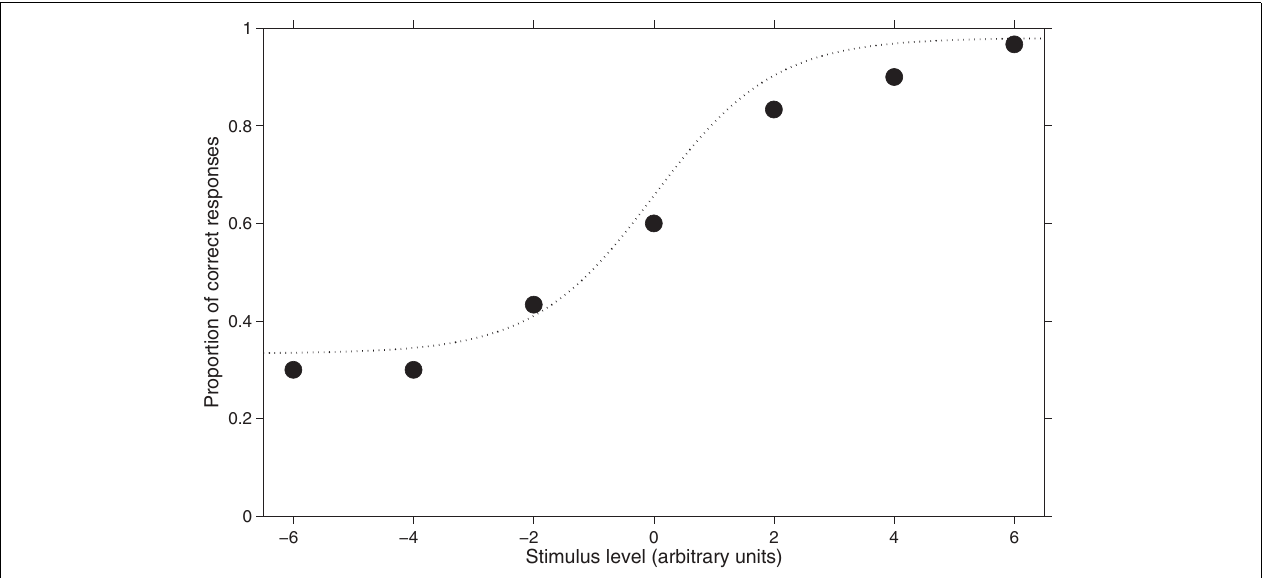
FIGURE 1 | Hypothetical results of a 3 AFC task. The dotted curve interpolating the subject’s data points is the psychometric function.